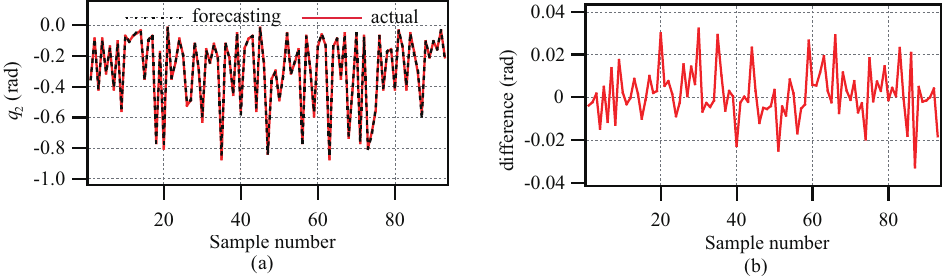
Figure 4. Validation results of BNN model: ( a ) forecasting and actual values; ( b ) difference between forecasting and actual